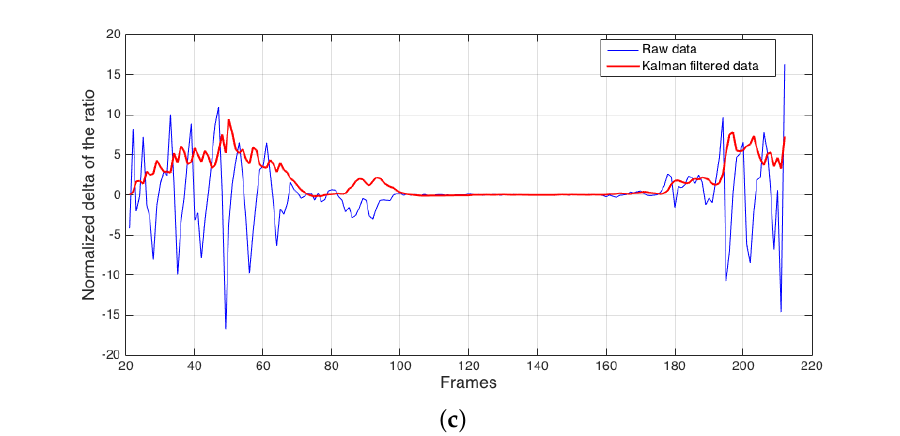
Figure 3. Example of a fall occurring perpendicular to the camera. ( a ) ratio; ( b ) angle; ( c ) normalized delta of the ratio.